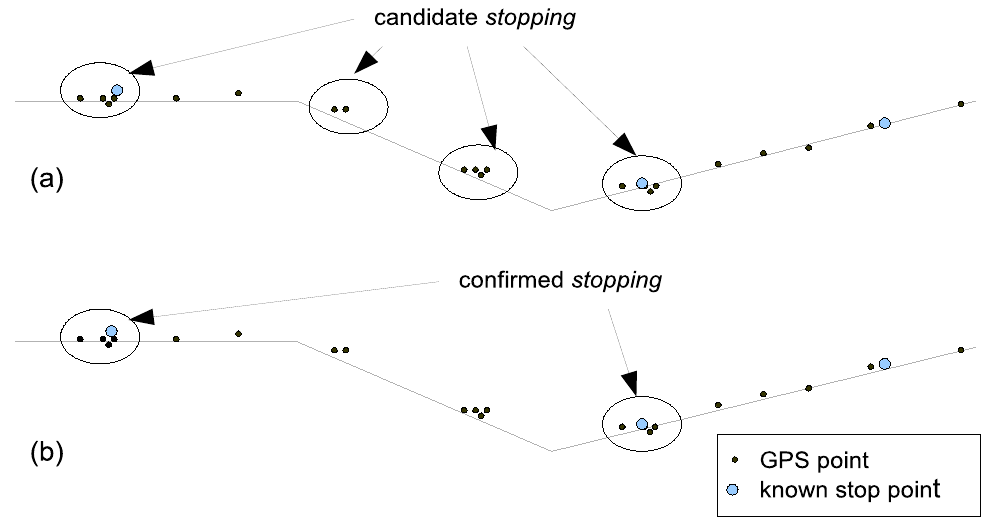
Figure 2. Extraction of stopping interactions.